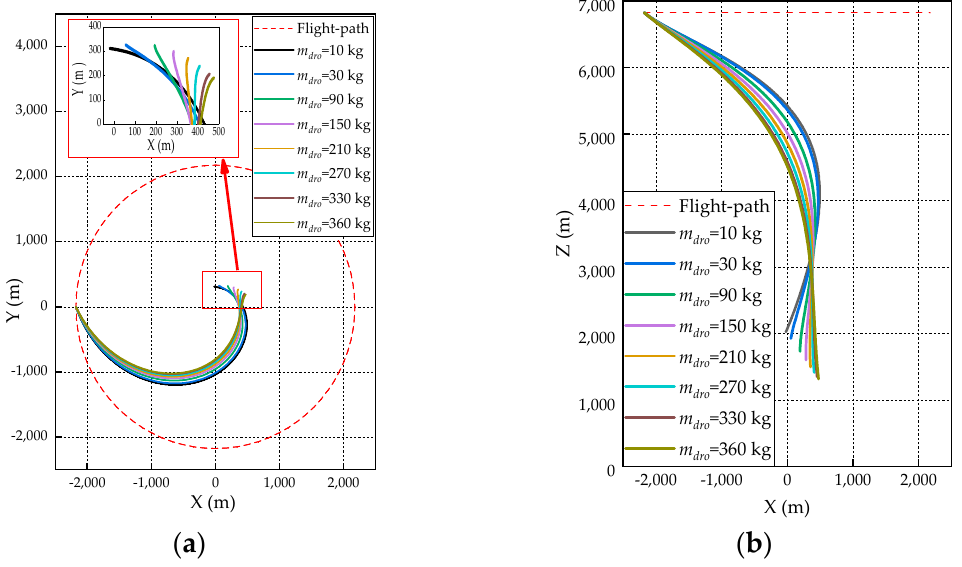
( b ) Figure 4. Towline spatial configurations vs. drogue drag characteristic: ( a ) Two-dimensional pro- jection in horizontal plane; ( b ) Two-dimensional projection in vertical plane. Figure 5. Verticality and towing force vs. drogue drag characteristic. 4.1.2. Drogue Mass To illustrate the effect of the drogue mass on the towing antenna system, the base towed antenna system parameters were kept the same, and only the drogue mass was